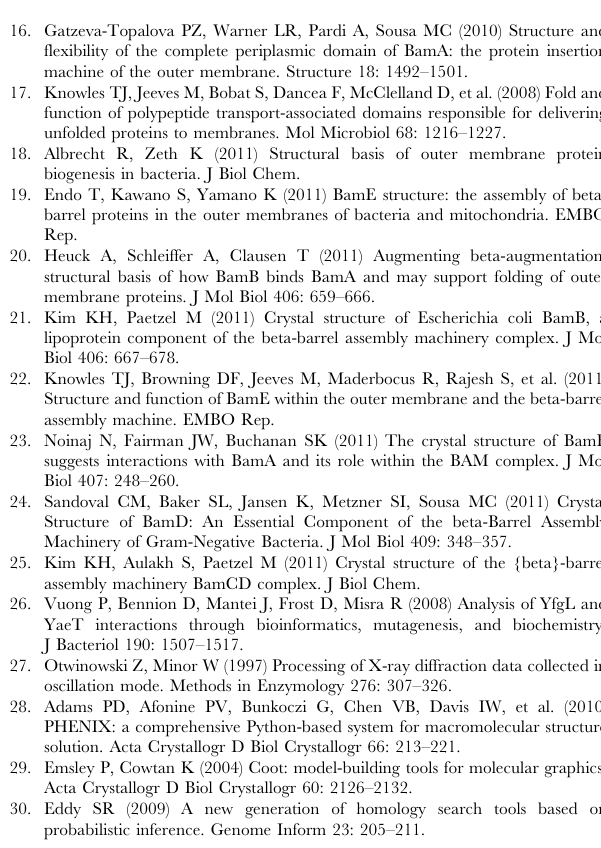
Figure S4 Representative ITC traces for the titration of b -barrel derived peptides on BamB. For each panel (A–D), the top plot represents the heat evolved after each injection ( m Cal/ sec) vs time; while the bottom section shows the enthalpy (kcal/ mol) as a function of peptide:ecBamB molar ratio (note: ‘‘the peptide into buffer titrations (panels B and D) show arbitrary numbers for ‘‘molar ratio’’ as no protein is present). The titration of 203 m M LamB peptide (sequence DFHGYARSGIGWT) on 25 m M ecBamB (A) is essentially the same as the titration of the same peptide solution into buffer (B). Similarly, titration of 1.5 mM BtuB peptide (sequence EYTLSGSYTF) on 17 m M ecBamB (C) was indistinguishable from the titration of the same peptide solution into buffer (D). We thus conclude that the observed signals are due to the heat of peptide dilution and no additional heat due to peptide binding to ecBamB is observed under these conditions. Titration of BtuB peptide was done at a large excess of peptide to account for the possibility of multiple binding sites. However, experiments carried out at peptide:BamB molar ratios in the range 1 to 3.5 were identical (data not shown), also indicating no detectable binding of the peptide to ecBamB.